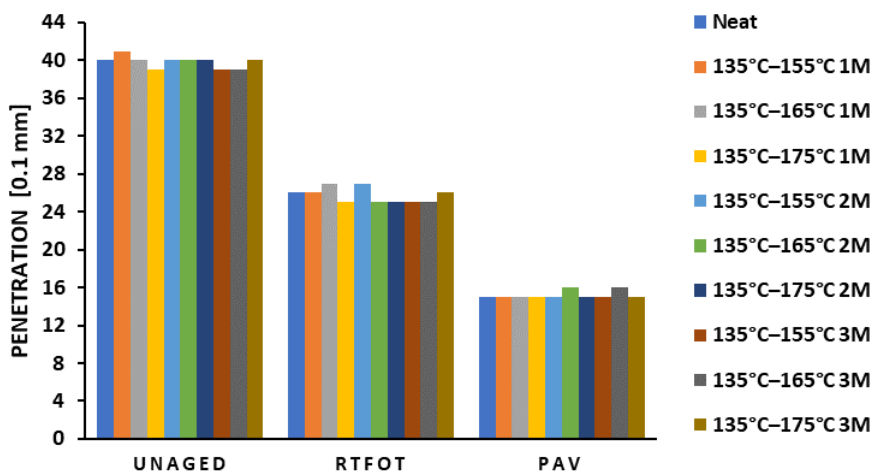
Figure 14. Penetration results of all samples at every aging stage.